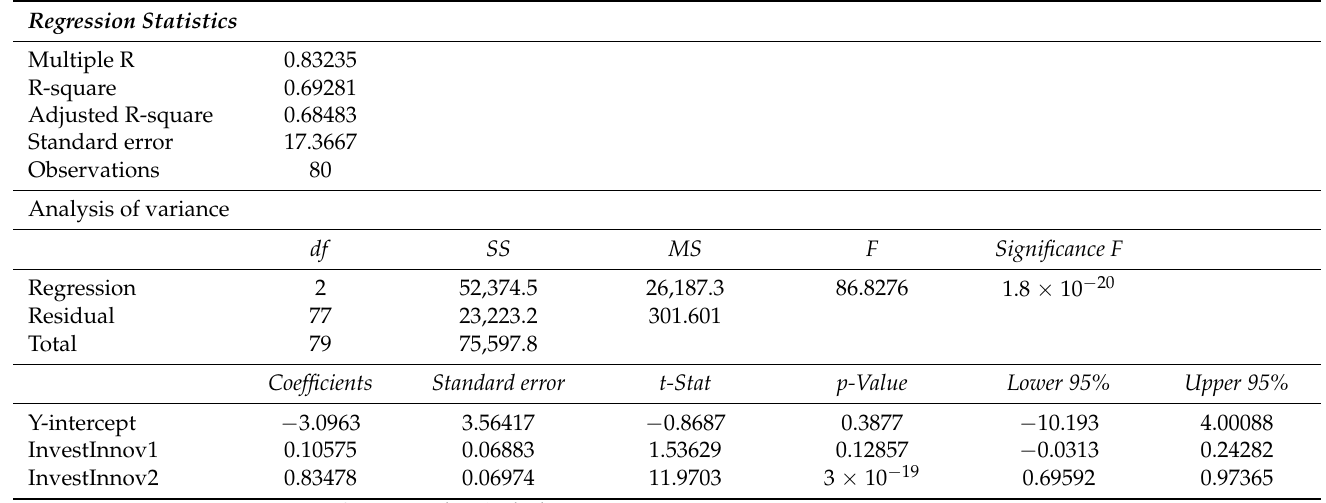
Table A4. Regression statistics of the dependence Srisk 4 on investments in innovation